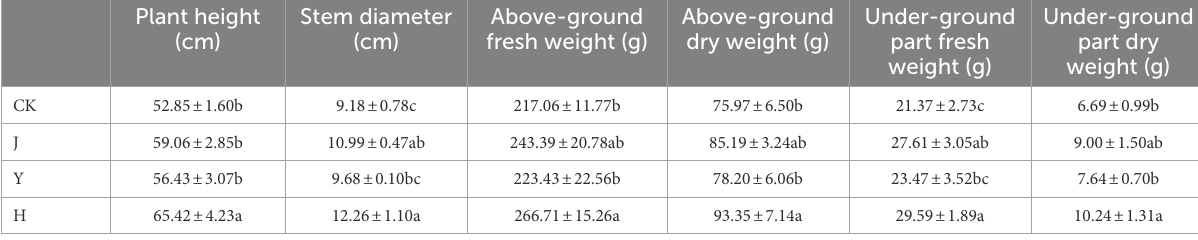
TABLE 3 Comparison of growth of soybean plants after treatment with various bacterial inoculants.